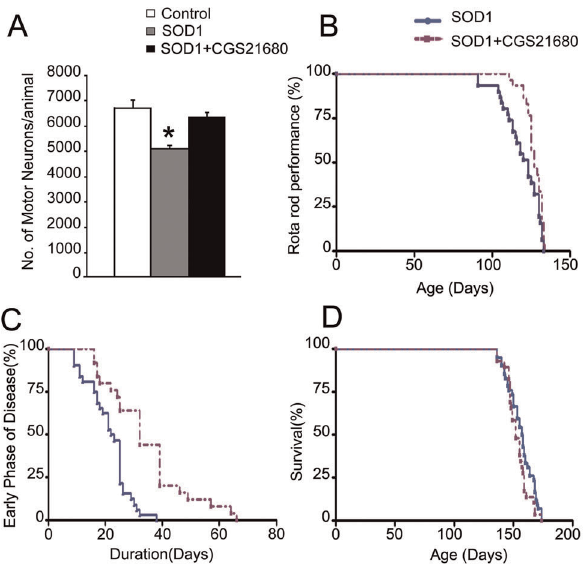
Figure 4. The adenosine A2A receptor agonist CGS21680 delays disease onset in SOD1 mutant mice. CGS treatment at 12 weeks of age significantly rescues motor neuron degeneration in SOD1 mice (A; p , 0.05). Analysis of rotarod data showing that treatment of SOD1 mice with CGS delays the impairment in rotarod performance by 7 days compared to untreated SOD1 mice (B; Kaplan Meier Analysis, p , 0.01). CGS treatment also prolongs the duration of the early phase of the disease by 12 days (C; p , 0.05) although it does not affect the mean life span of the SOD1 mutant animals (D).